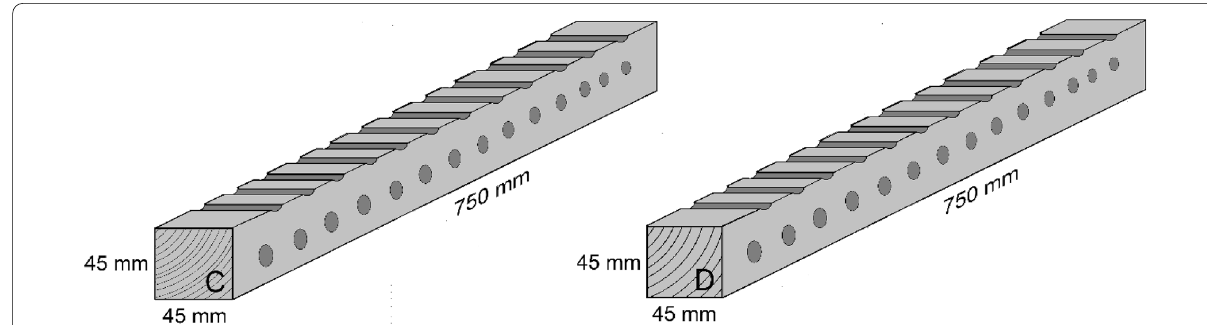
Fig. 2 Shape, dimensions and graining of beech specimens (samples C and D) with outline of ball and cylindrical indentations (samples A and B were cut into cubes and set aside for a completely different cross‑section hardness test)